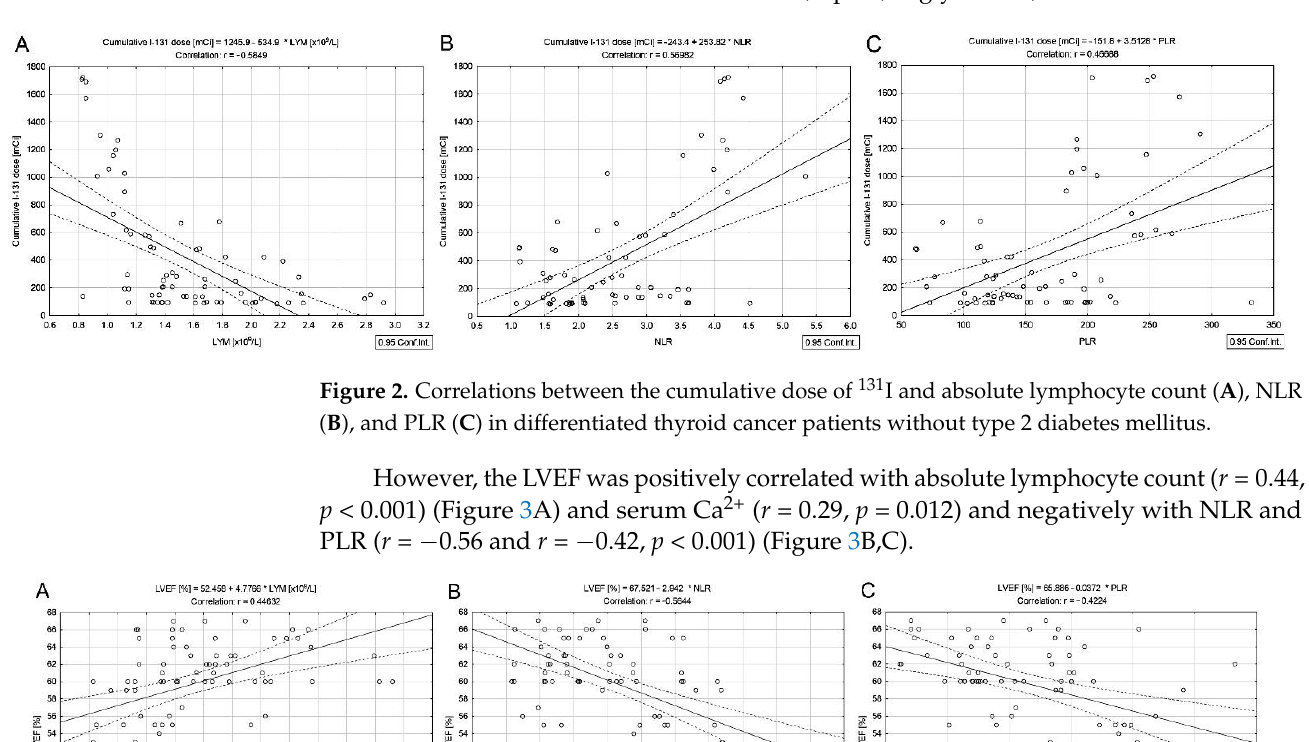
Figure 1. Correlations between the cumulative dose of 131 I and LVEF ( A ), serum concentrations of